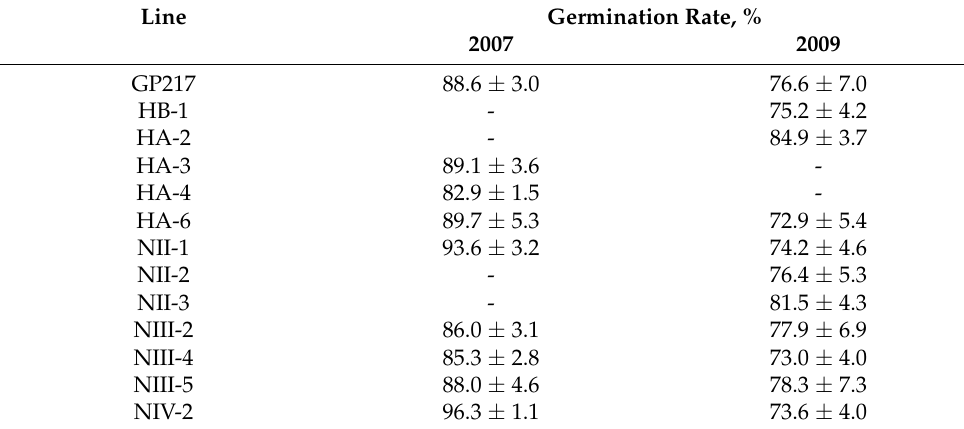
Table 4. Germination of transgenic pear seeds.